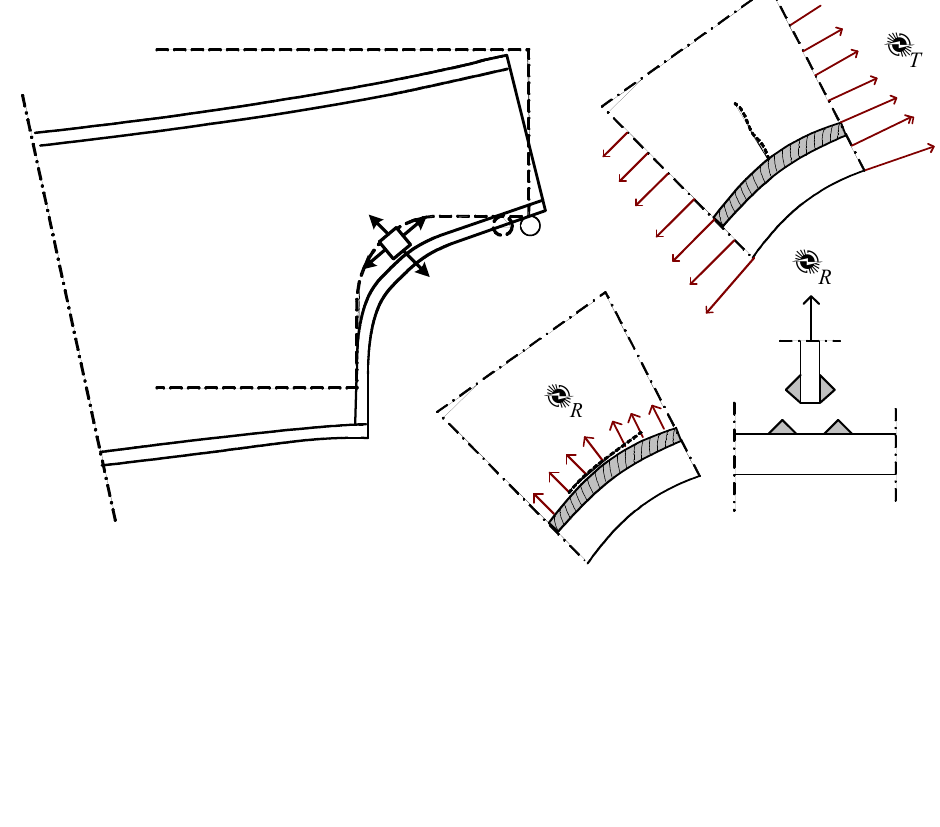
Figure 4. Tangential and radial stresses in beams with reduced depth and the three cracking modes that can occur in this